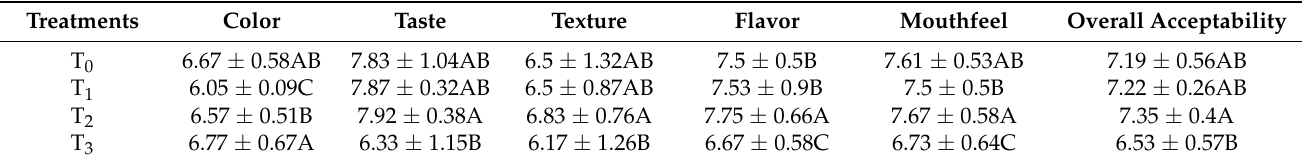
Table 5. Sensory evaluation of nuggets supplemented with O. basilicum essential oil on a 9-point hedonic